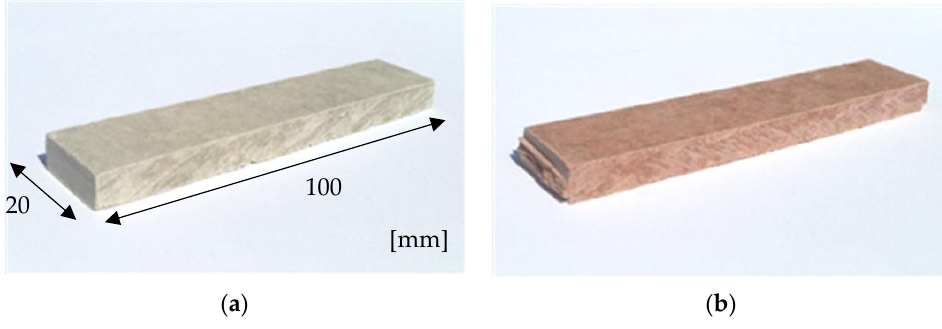
Figure 2. Tested fibre-cement board samples: ( a ) board A, ( b ) board C.